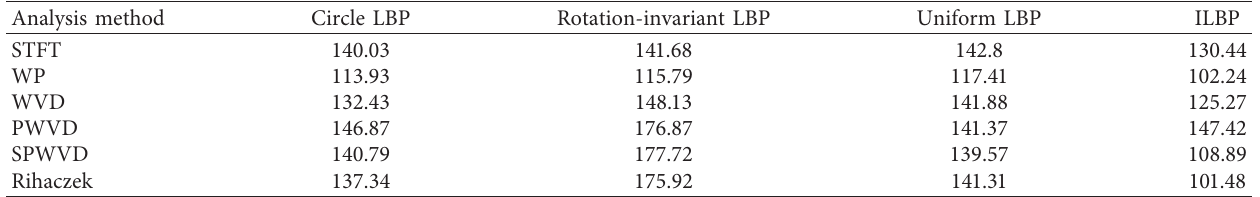
Figure 15: Fault diagnosis results of diesel engine based on the LBP operator. (a) Results by NNC classifier. (b) Results by SVM classifier. Table 3: Time consumption in extraction of LBP features for different time-frequency images (units: 10 2 s).